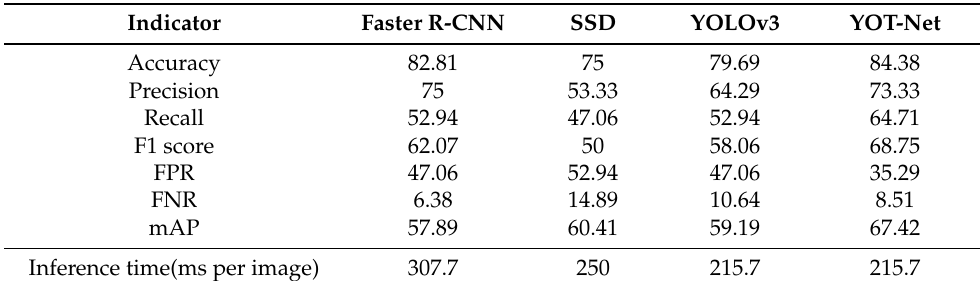
Table 3. Comparisons with other detection methods.